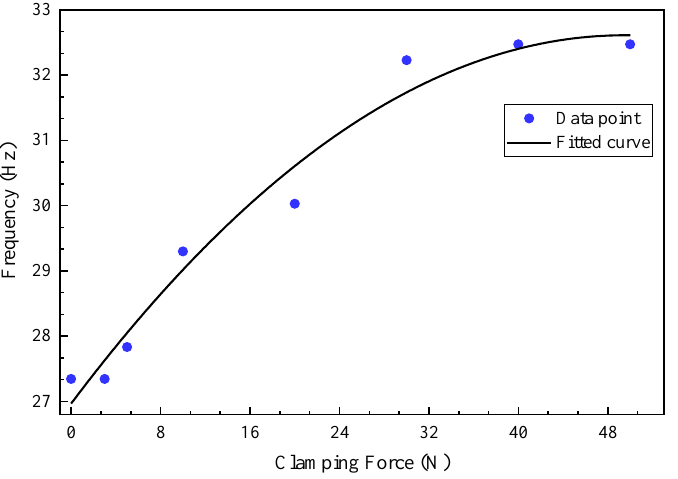
Figure 6. Natural frequencies of the first order under different clamping forces (double-span tube).